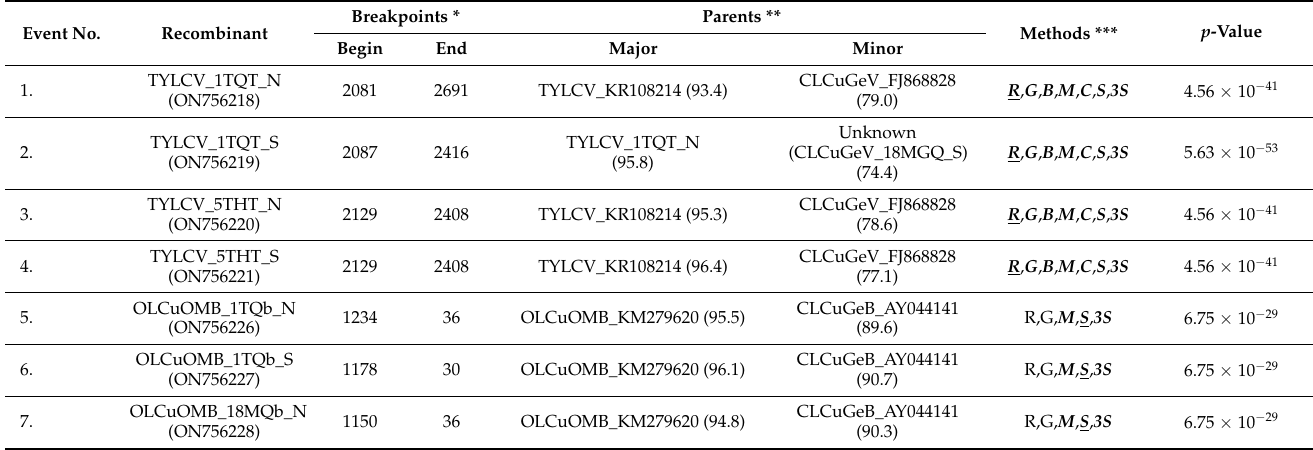
Table 2. Recombination detection using seven different methods in